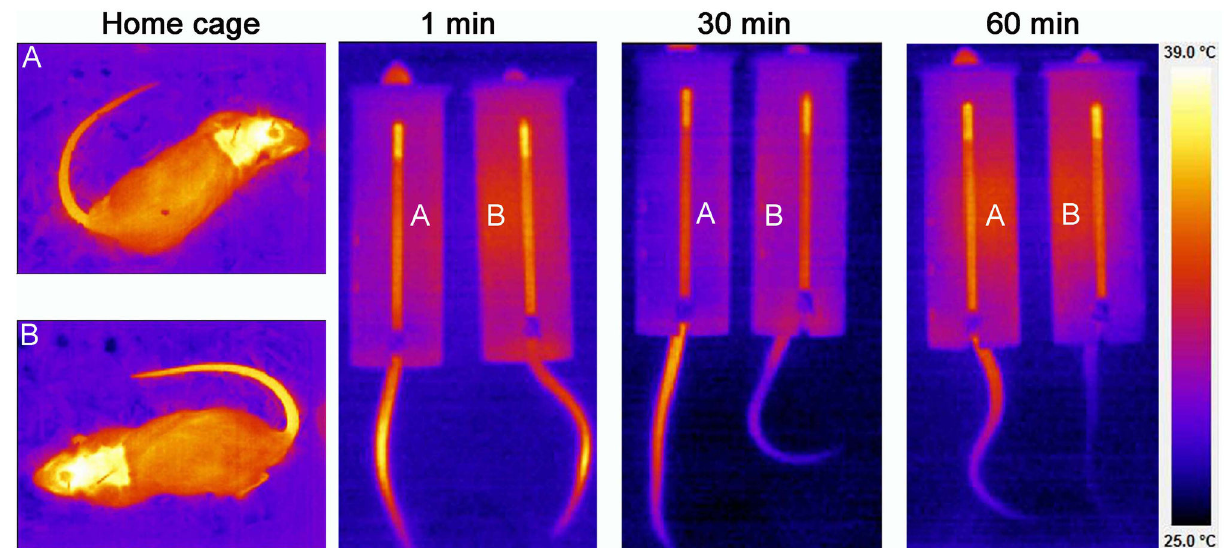
Figure 3. Infrared digital images of representative rats which received either CoCl2 (indicated by A) or vehicle (indicated by B) into DH, in its home cage and during the first minute, thirty and sixty minutes of restraint. Note the drop in cutaneous tail temperature during the restraint in vehicle treated animal and the absence of this drop in CoCl2 treated animal. The same effects were observed in VH treated animals. All images use the same color-coding for temperature. doi: